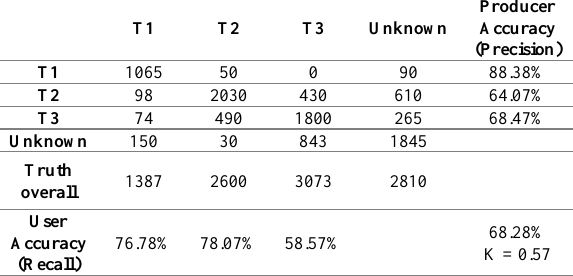
Figure 3. The Pleiades SVM classified map.